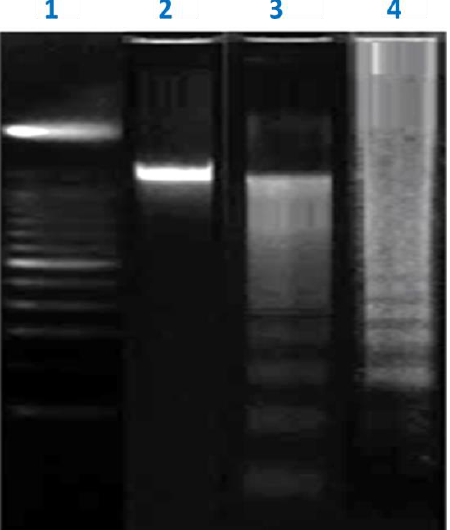
Figure 7. Electrophoretic pattern of DNA fragments isolated from HepG2 cells on 8% agarose gel electrophoresis. Lane 1: DNA marker, 100-bp. Lane 2: the intact DNA of the untreated HepG2 cells. Lane 3 and 4: the fragmented DNA of HepG2 cells treated with 25 and 50 μg/mL of R. nomadica venom, respectively.